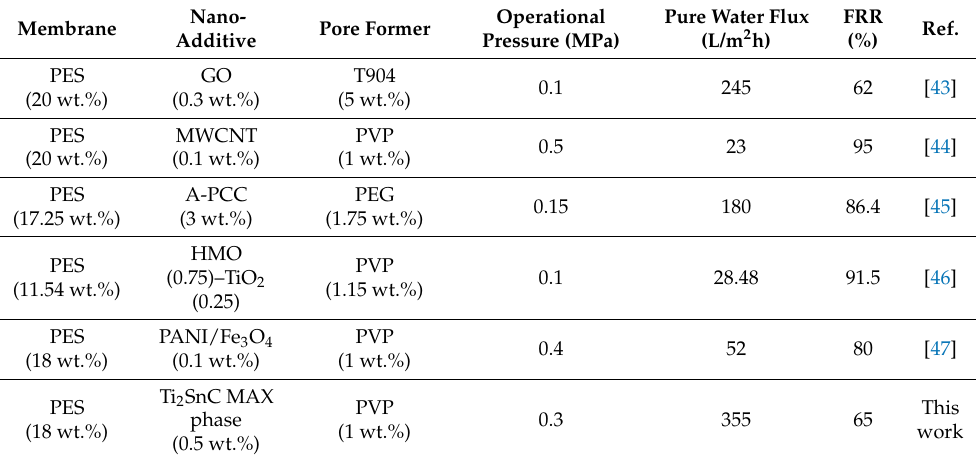
Table 2. Collation of the efficiency of the 0.5 wt% Ti 2 SnC MP/PES membrane with other PES-based blended membranes in the